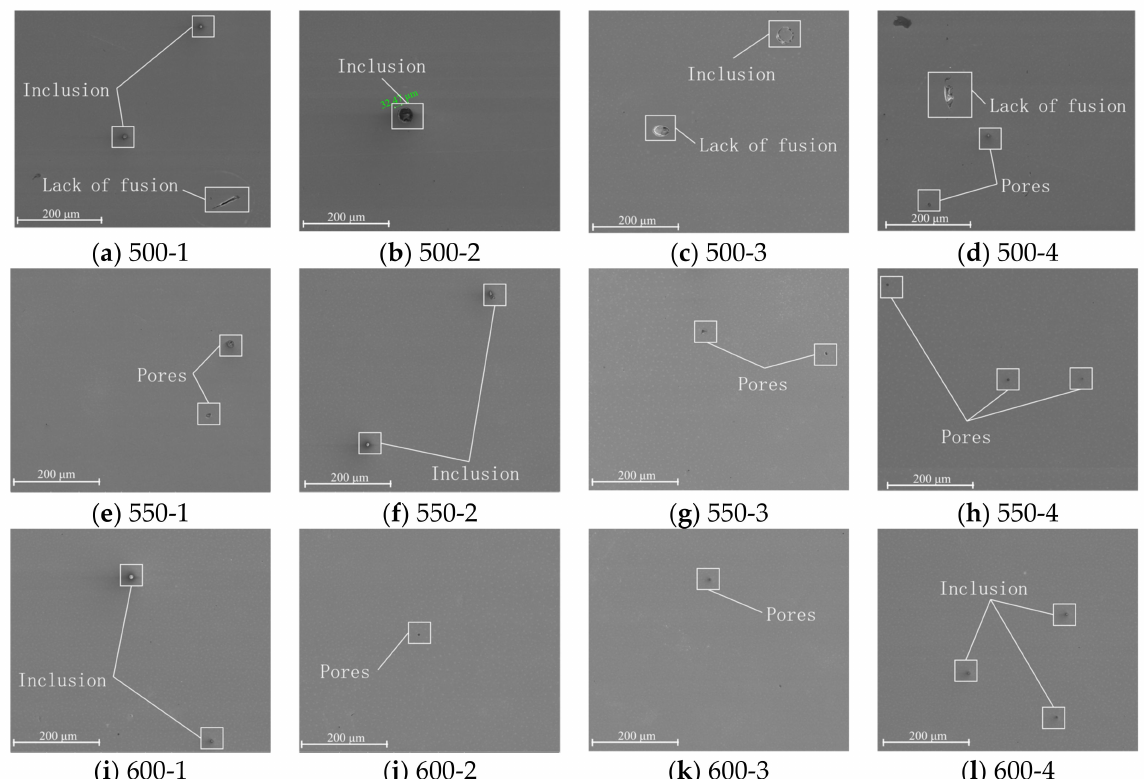
Figure 7. The microstructures of 316L sample fabricated with different shielding gas volume